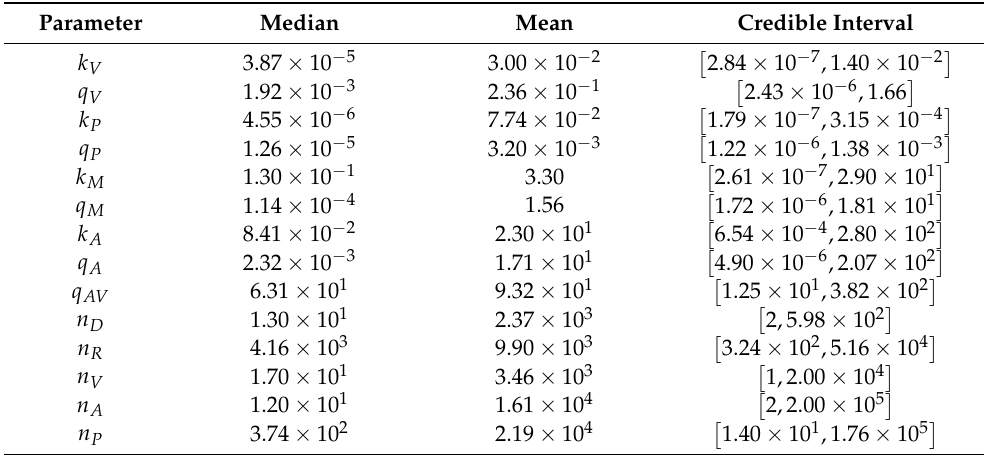
Table 6. Summary statistics for each accepted parameter value sets from model 3. Mean, median and a 95% credible interval are summarised in the